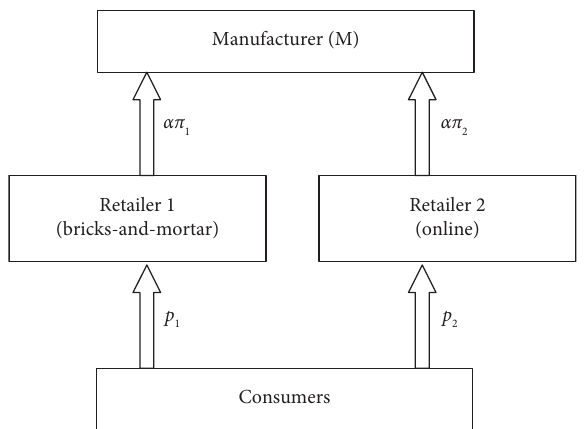
Figure 2: Centralized model ( p